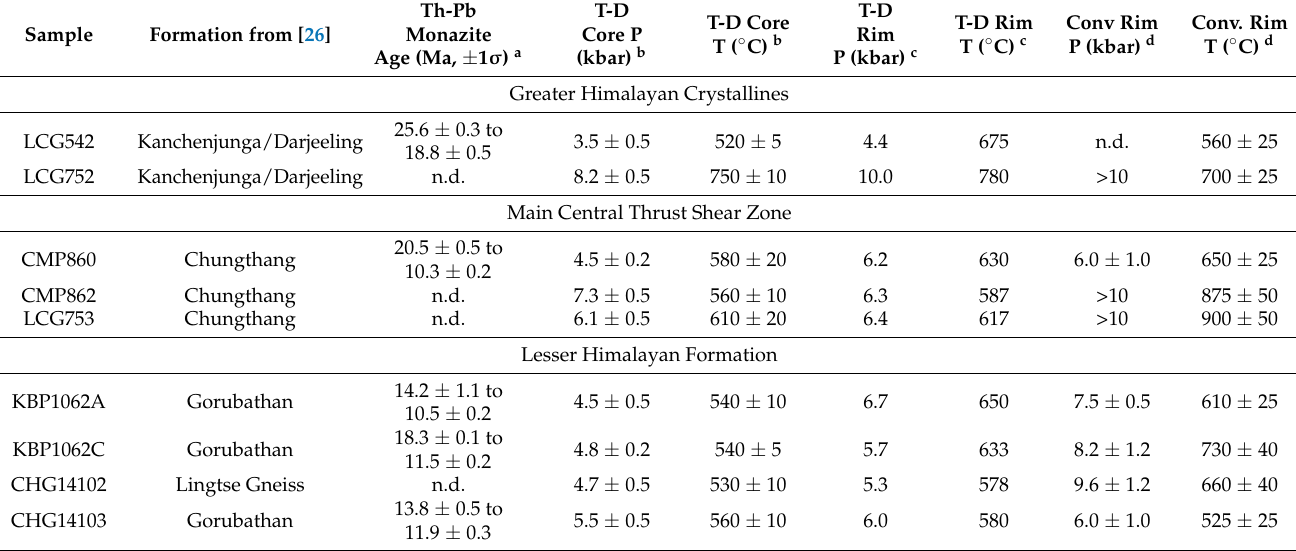
Table 1. P-T-t information from samples collected and analyzed in this